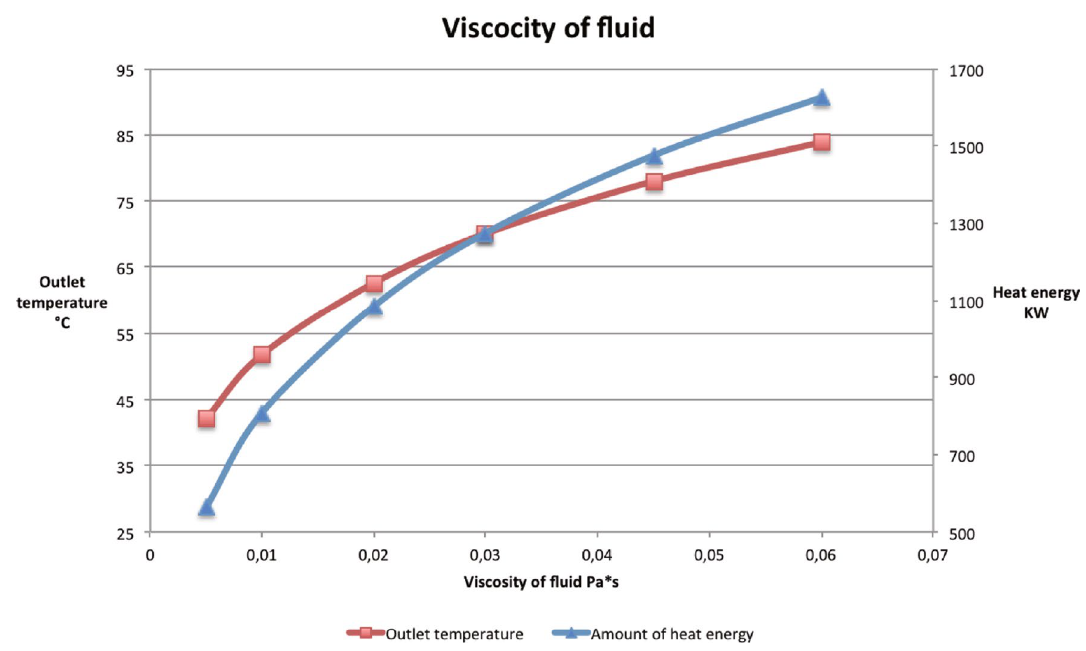
Fig. 5 Temperature and heat energy regarding working fluids’ viscosity